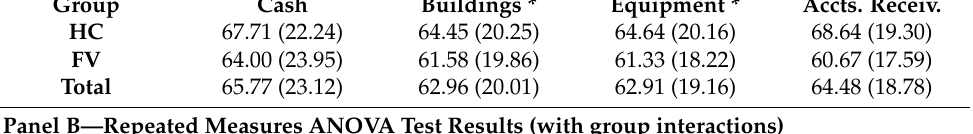
Panel B—Repeated Measures ANOVA Test Results (with group